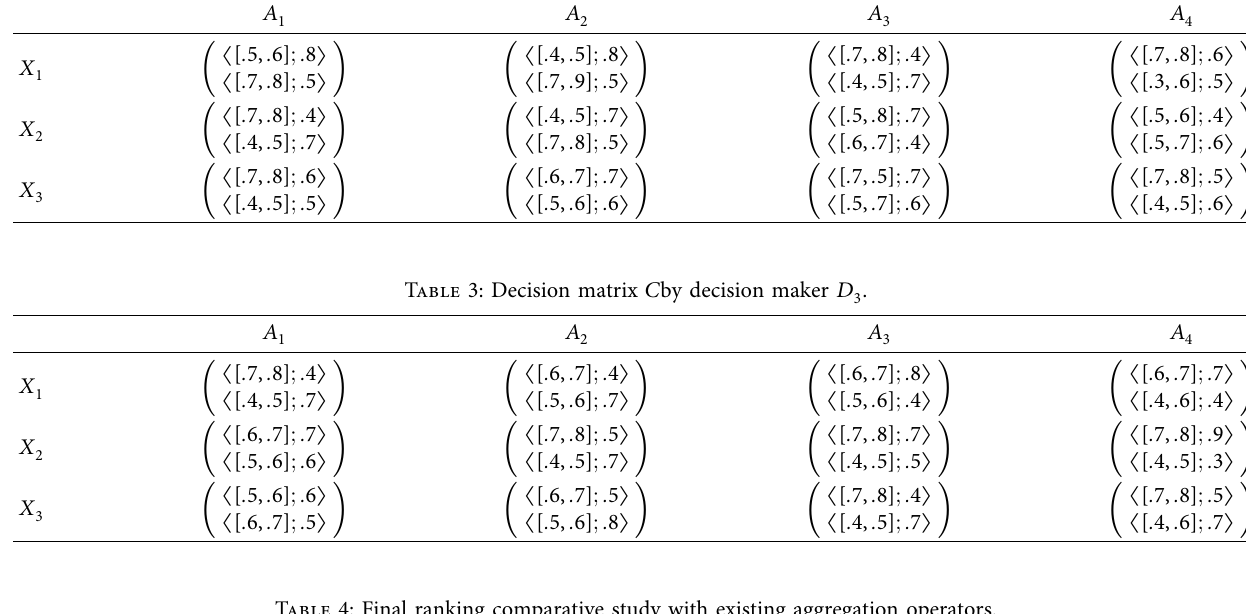
Table 2: Decision matrix C by decision maker D